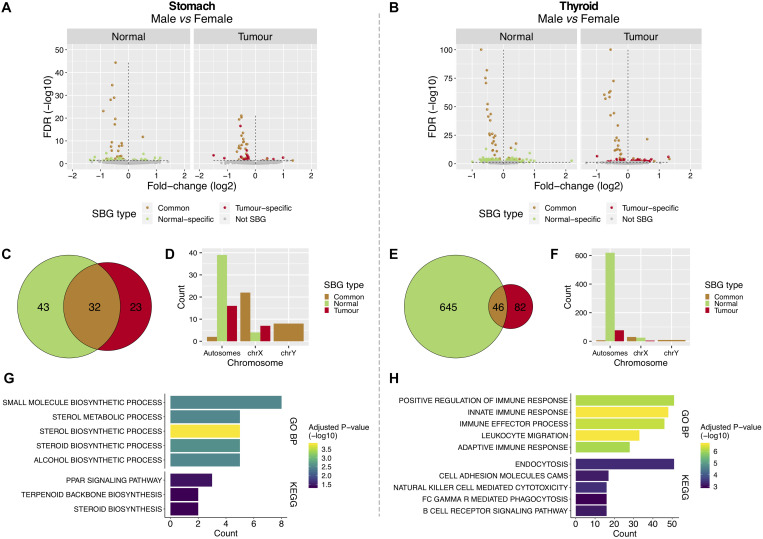
Features of sex-biased genes in tumor and normal stomach and thyroid tissues. (A,B) Differentially expressed genes between males and females in normal [Genotype-Tissue Expression (GTEx)] and tumor [The Cancer Genome Atlas (TCGA)] tissues from the stomach and thyroid. The Y-chromosome genes and XIST were removed for visualization purposes. Vertical lines: left, genes over-expressed in females (under-expressed in males); right, genes under-expressed in females (over-expressed in males). (C,E) Shared and tissue-specific sex-biased genes (SBGs). (D,F) Distribution of SBGs in autosomes and sexual chromosomes. (G,H) Gene Ontology (GO) biological processes (GO BPs) and Kyoto Encyclopedia of Genes and Genomes (KEGG) pathways enriched in the normal-specific SBGs [top 5; false discovery rate (FDR) < 5%].